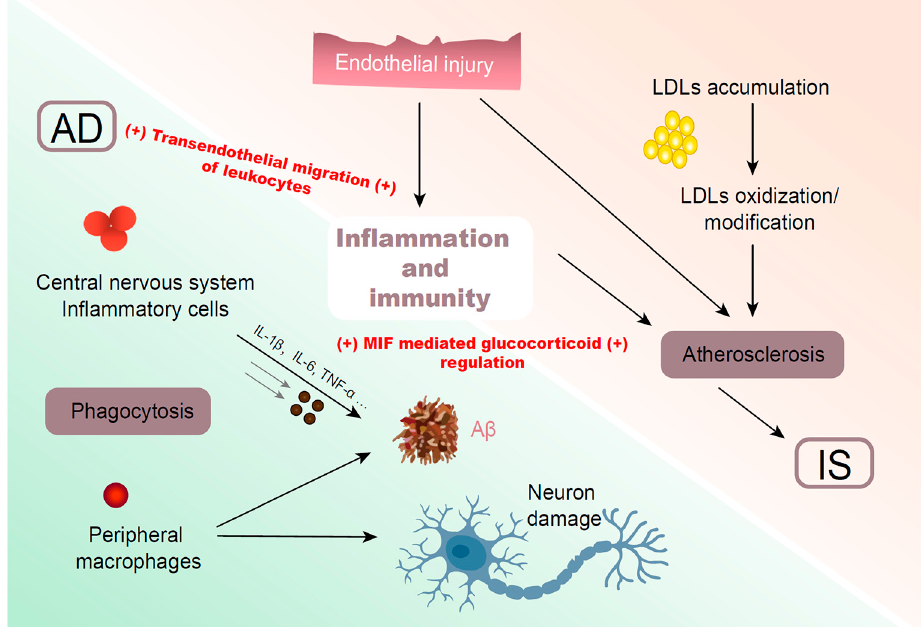
Figure 3. The involvements of inflammation and immunity in AD and IS. Abbreviation: A β : amyloid β ; AD: Alzheimer’s disease; IL-1 β : interleukin-1 β ; IL-6: interleukin-6; IS: ischemic stroke; LDL: low density lipoprotein; MIF: macrophage-migration inhibitory factor; TNF- α : tumor necrosis factor- α ; +: promote the progression.